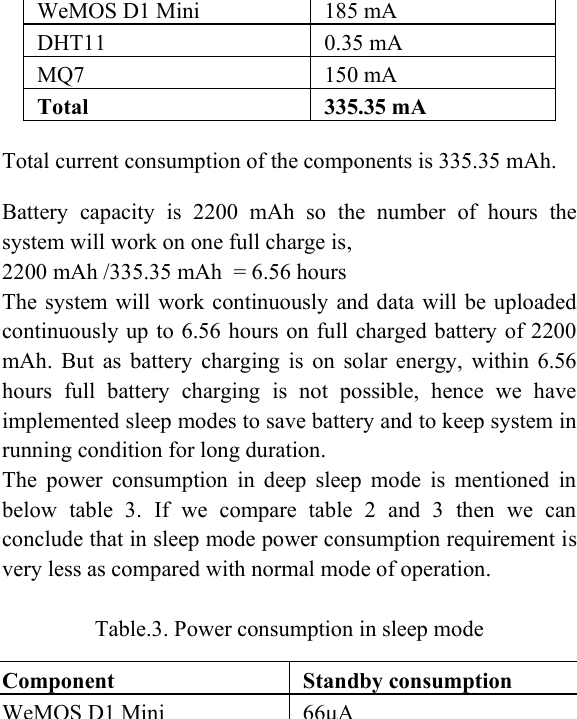
Figure.1. Block diagram of the system